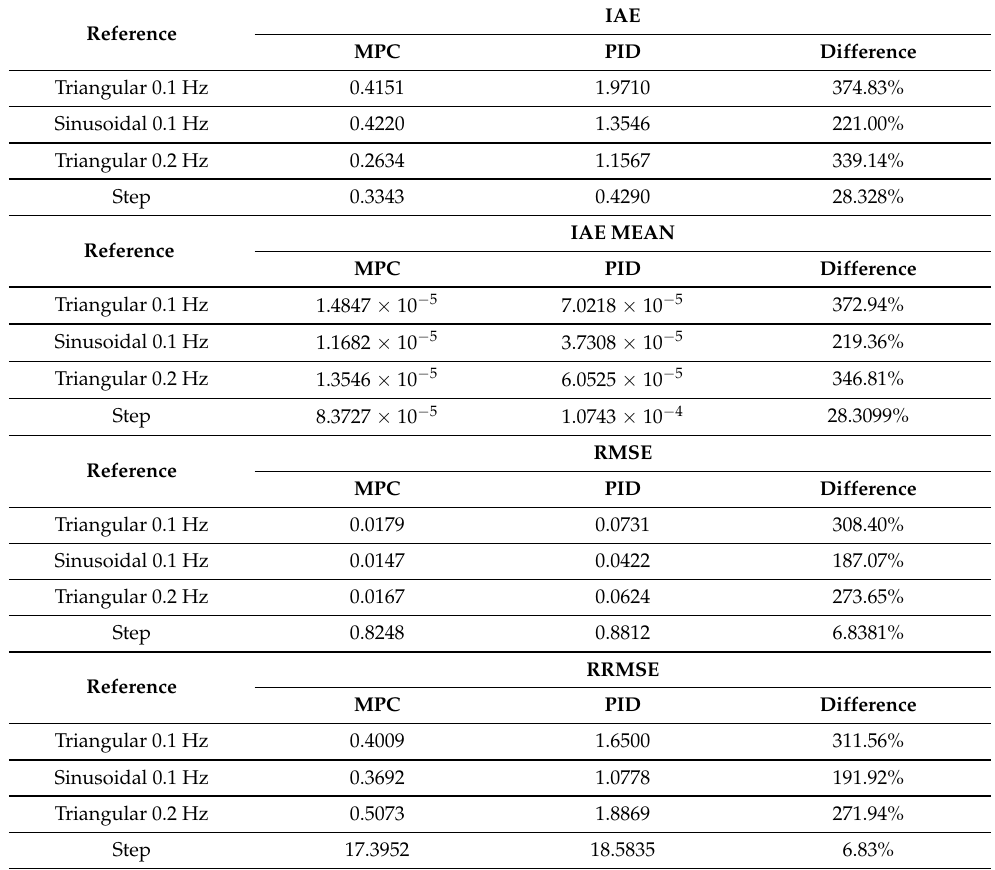
Table 7. Error comparison between MPC and PID with different source